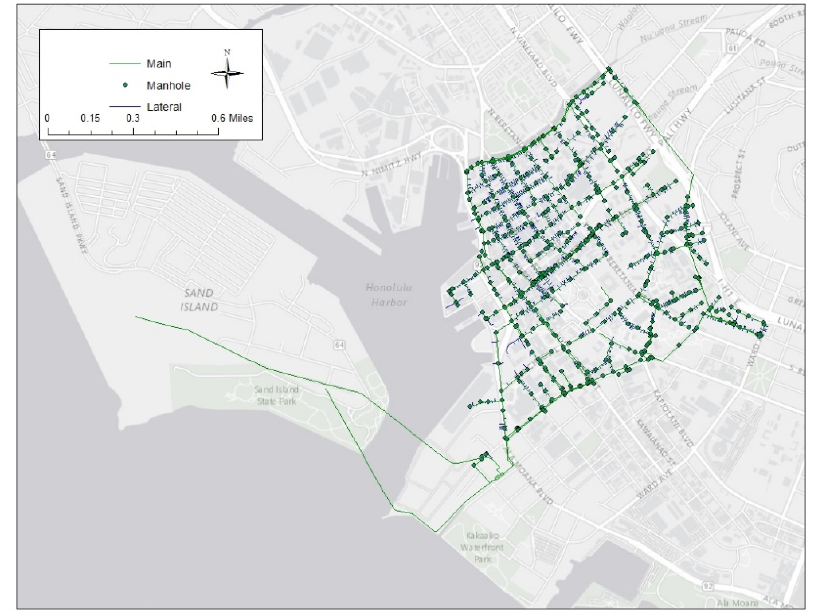
Figure 2. Downtown Honolulu, HI case study area for the system-wide groundwater infiltration (GWI) assessment.